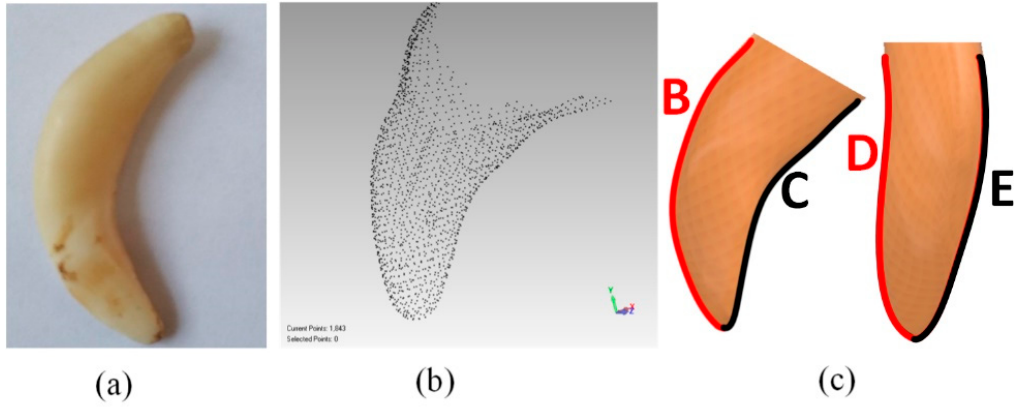
Figure 1. The badger canine. ( a ) The real badger canine. ( b ) The point cloud of the canine involving the front 15 mm. ( c ) The 3D model and selected outlines of badger canine.